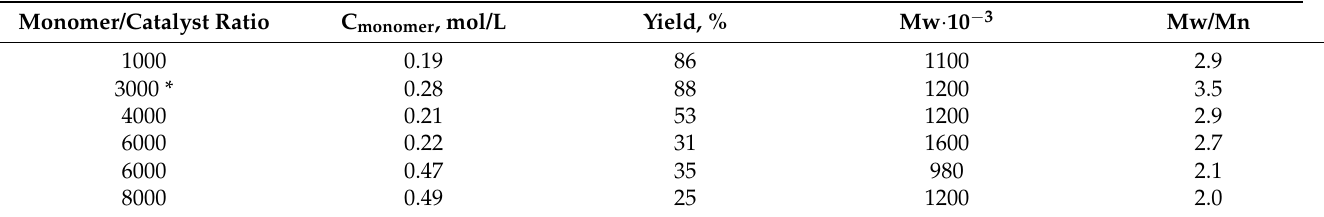
Table 1. Polymerization conditions of NBPh and their influence on the characteristics of the polymer. Monomer/Catalyst